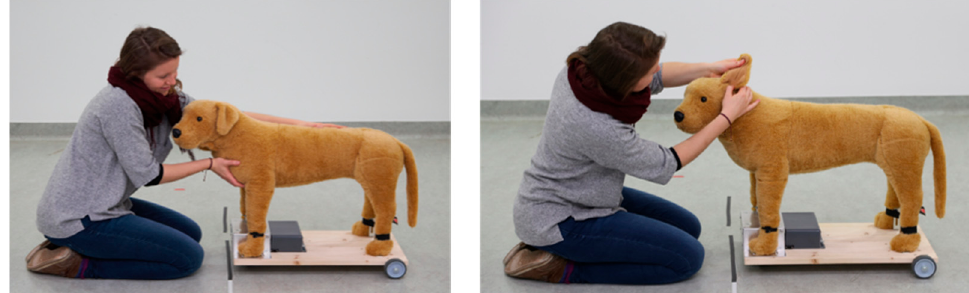
Figure 2. Human–fake dog interaction. Human (caregiver or experimenter) greeting ( left ) and vet check ( right ) performance with fake dog.